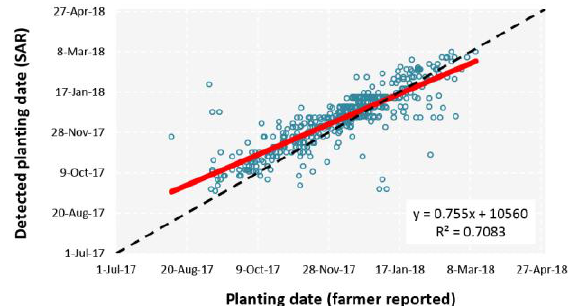
Figure 4. Comparison between the estimated SoS-derived dates from SAR and actual planting dates reported by farmers in selected rice fields in four provinces in the Philippines for 2018 Semester 1. One dot corresponds to one monitoring field.